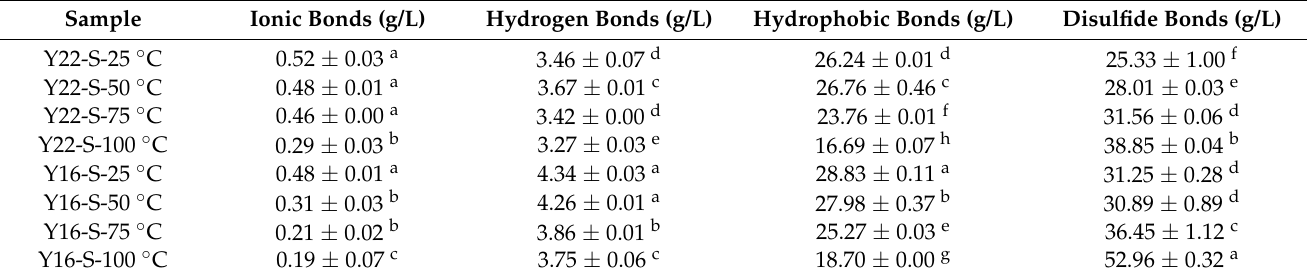
Table 3. Chemical interaction changes in different gluten–starch mixtures during heating.